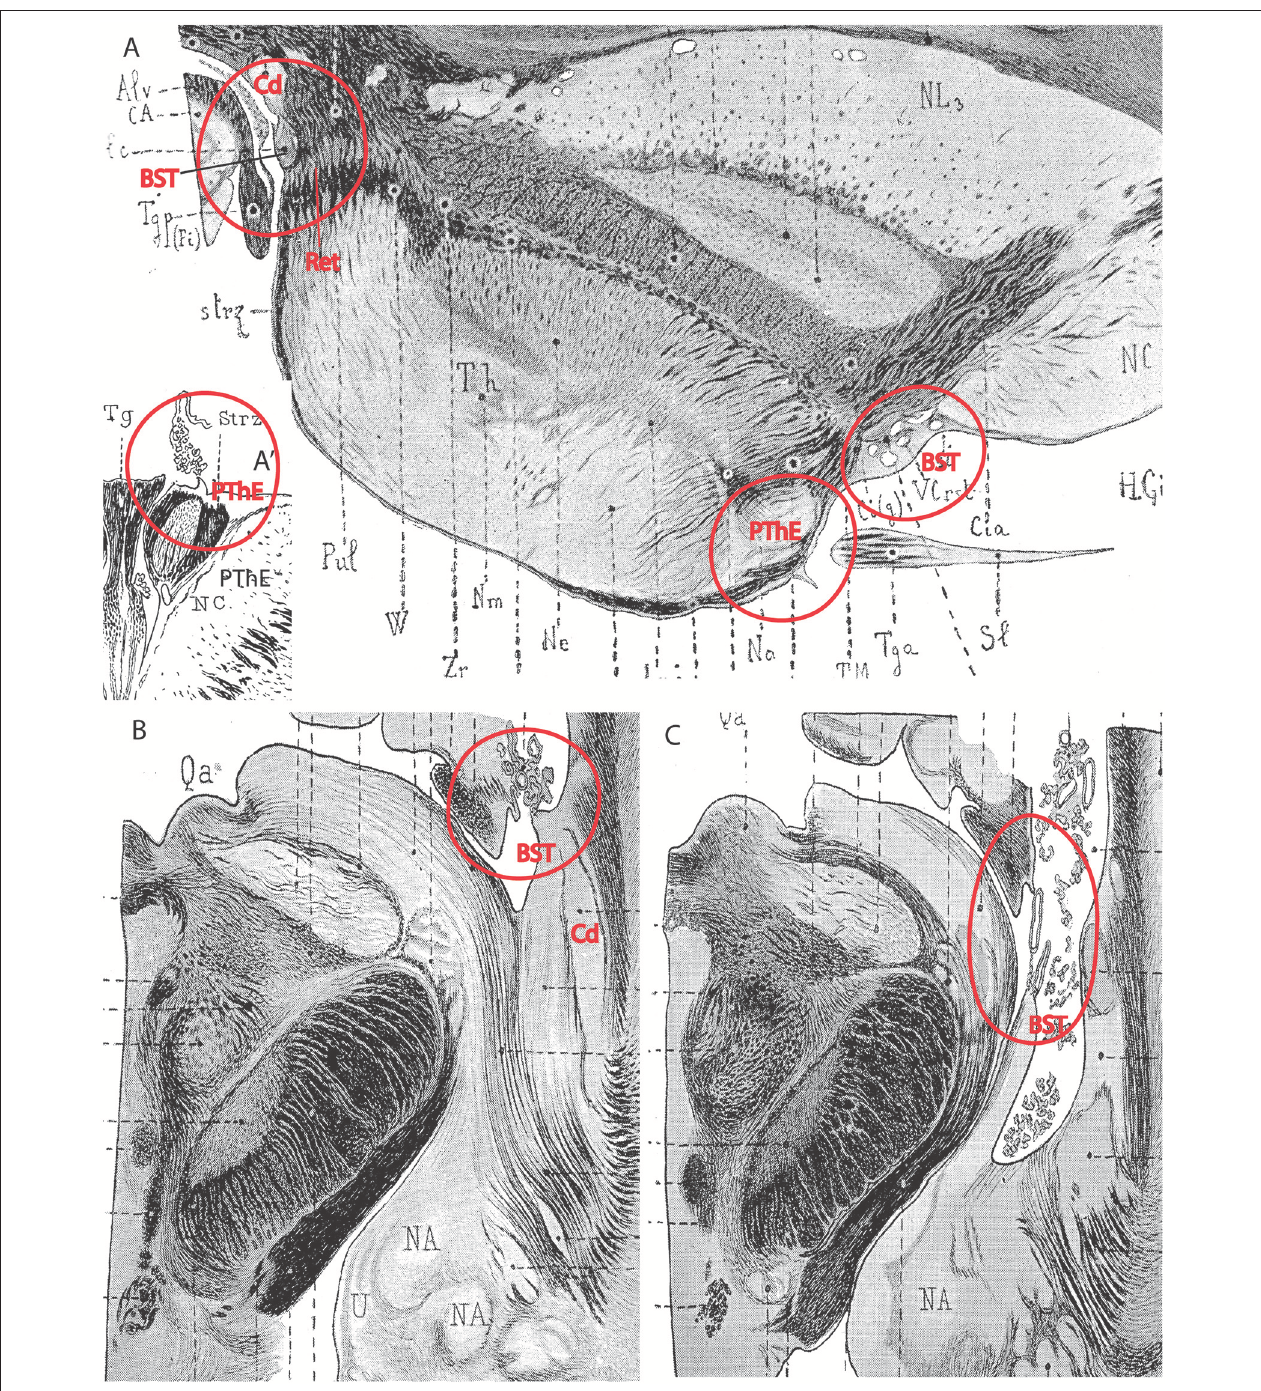
FIGURE 12 | This plate brings together four separate drawings (or drawing details) modified by red annotations, taken from the work of the French neuroanatomist Dèjerine (1895) on the adult human brain (no copyright permission required). They illustrate my new interpretation of the roof-plate-derived chorioidal insertions (taeniae) associated to thalamic, prethalamic and telencephalic structures, as presented in Figure 11C (and negating what I call the lamina affixa myth). The Dèjerine (1895) work is one of the few places where this issue can be examined objectively in the adult human brain, because it contains very precise drawings of numerous sections in various planes. Other similarly useful material (not shown) is embryonic and can be found, e.g., in the human developing brain atlas of Hochstetter (1919), and other works showing abundant sections of appropriate embryonic material at high magnification. Dèjerine’s drawings frequently depict the chorioidal tela insertions without deterioration, probably thanks to the celloidin embedding method used, which preserved the delicate chorioidal tela (normally torn or fragmentary in many published sources where sections from hand-dissected brains are shown). My thesis is that the classic lamina affixa theory (see text of Figure 11A